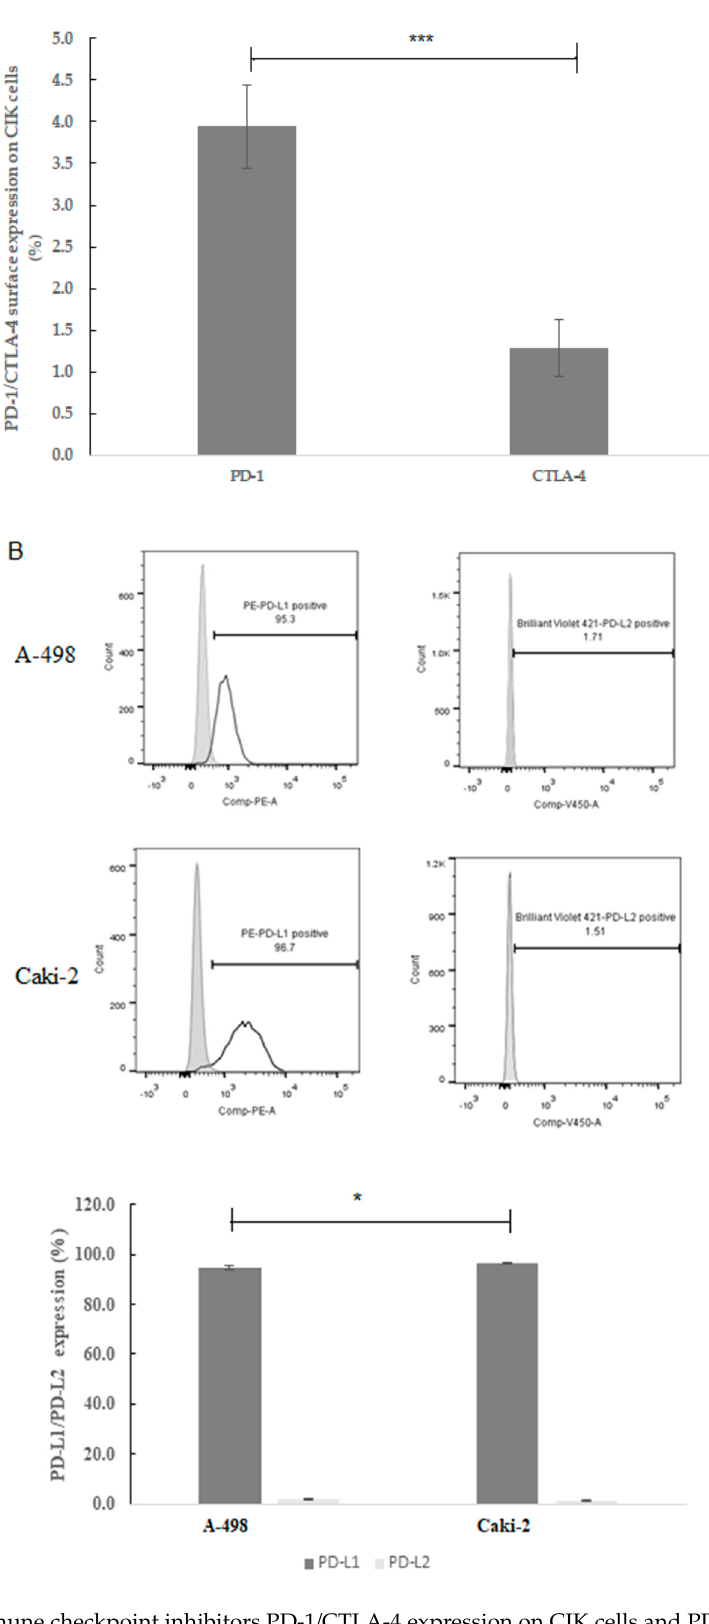
Figure 2. Immune checkpoint inhibitors PD-1/CTLA-4 expression on CIK cells and PD-L1/PD-L2 expression on A-498 and Caki-2 cells. ( A ) Representative flow cytometric bar plots show PD-1 and CTLA-4 expression in CD3 + CIK cells. ( B ) Representative flow cytometric histogram plots show the differences in PD-L1/PD-L2 expression on A-498 and Caki-2 cells. The grey filled lines represent the isotype control. The bold lines represent PD-L1/PD L2-stained tumor cells. All the data represents